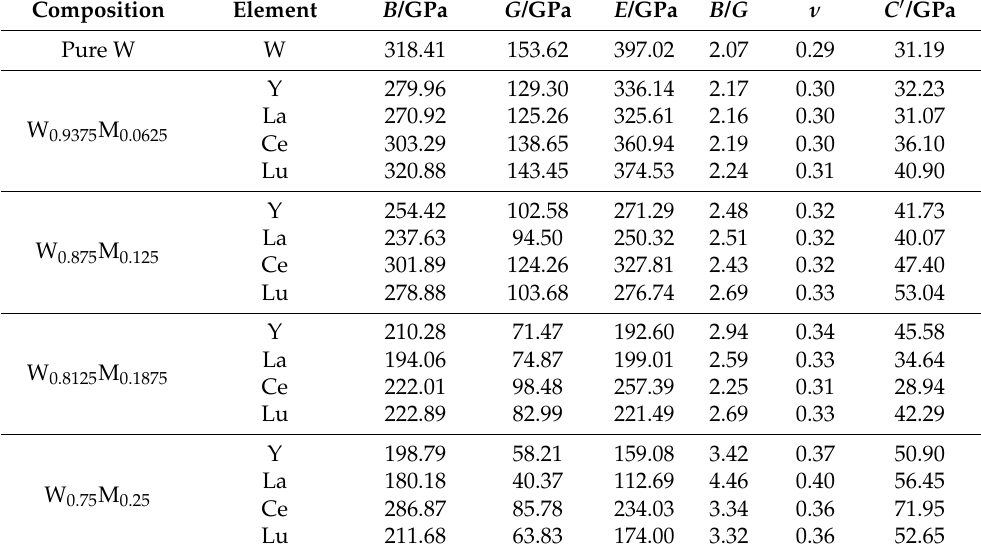
Composition Element B /GPa G